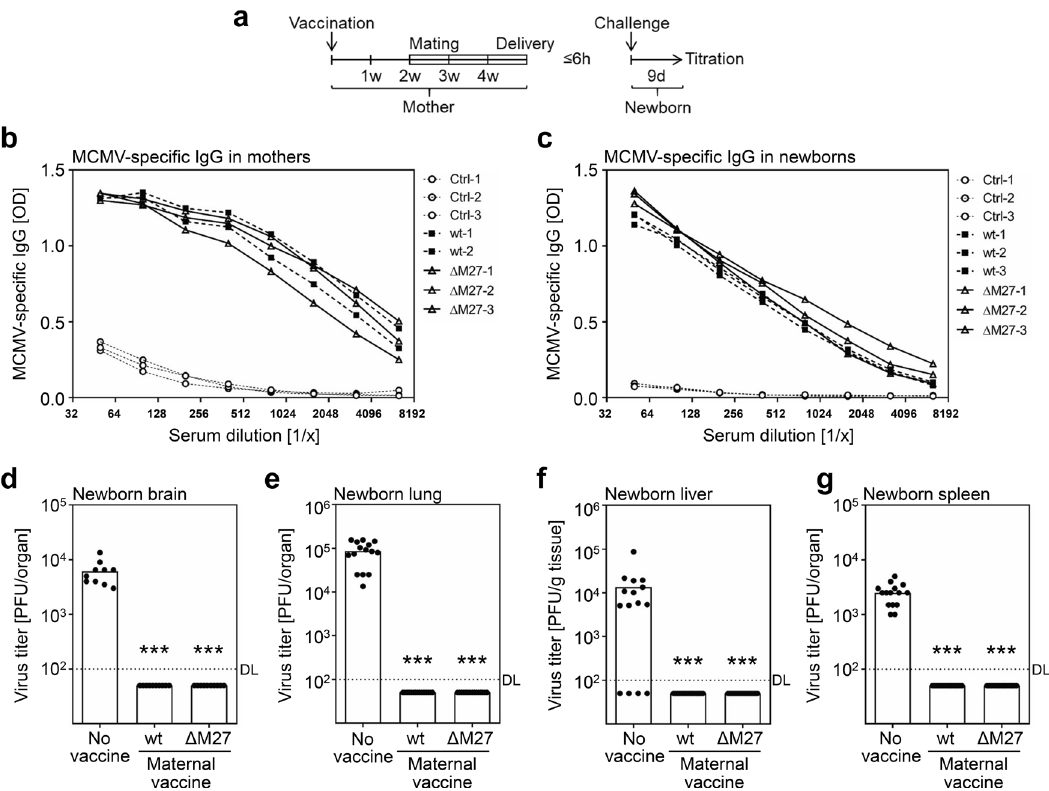
Fig. 8 Vaccinated female mice transmit MCMV-speci fi c IgG and protection to their offspring. Female BALB/c mice were vaccinated with wt- MCMV or Δ M27-MCMV. At 5 weeks post vaccination, mice were mated to analyze the protection of the offspring. At ≤ 6 h postpartum, groups of fi ve newborns derived from three dams ( n = 5 × 3) were challenged i. p. with 500 PFU of MCMV:eGFP per mouse. At 9 d post challenge, the indicated organs were harvested and virus titers were determined by plaque titration. a Schema of the experimental design. The presence of MCMV-speci fi c IgG was tested by ELISA for dams ( b ) and their offspring ( c ). ELISA reactivity of different dilutions of serum samples was analyzed. Values of individual serum dilutions and individual mice are shown. d Virus titers of brains of pups. e Virus titers of lungs of pups. f Virus titers of livers of pups. g Virus titers of spleens of pups. Bars depict the geometric mean, dots show the titers of individual mice. DL detection limit. All vaccinated groups were compared to the corresponding control group by Kruskal – Wallis test corrected for multiple comparisons by controlling the false discovery rate. *** p value